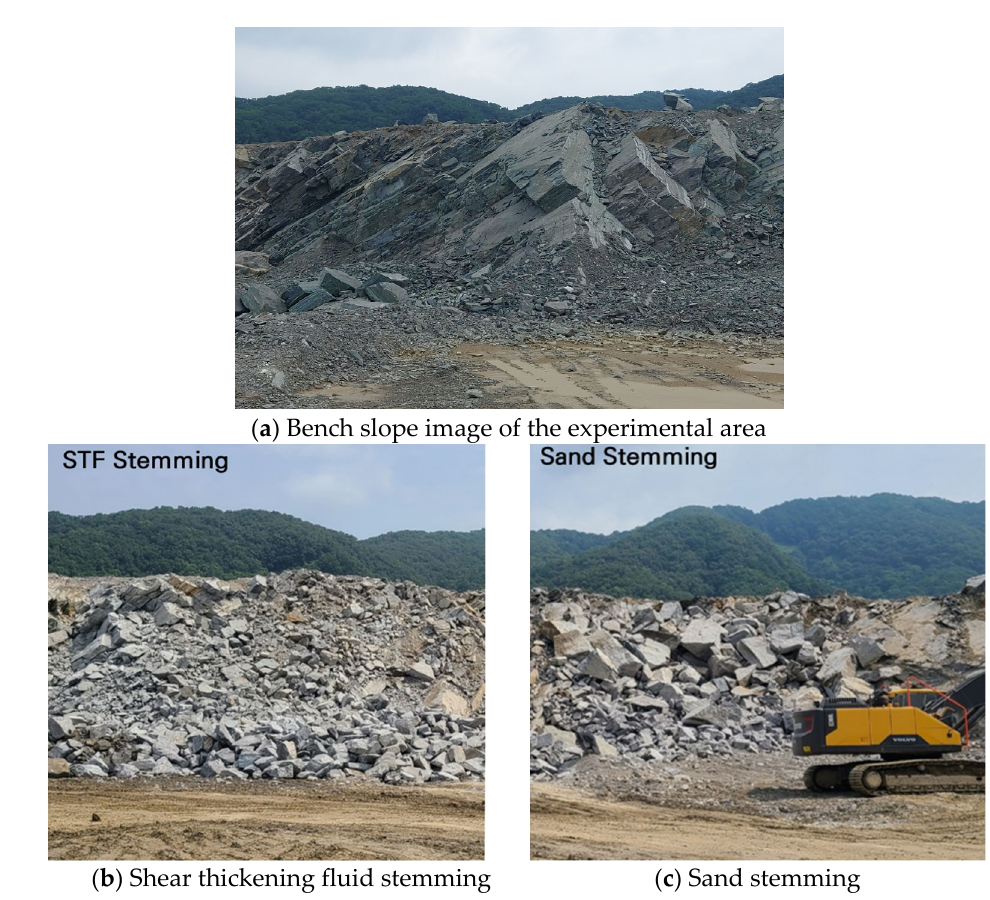
Figure 11. Bench blasting results obtained by applying different stemming materials.